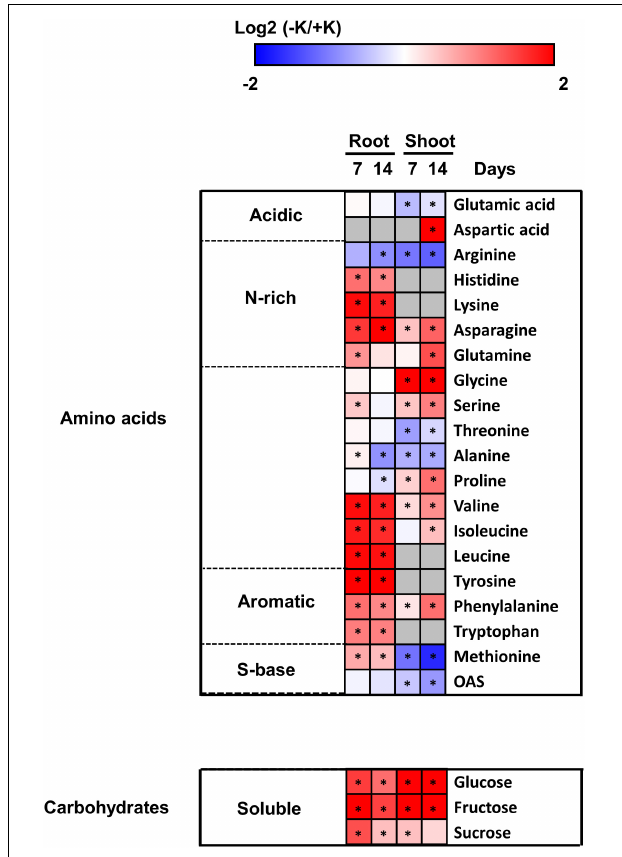
FIGURE 6 | Heatmap representation of primary metabolites in rapeseed plants exposed to K deficiency. The calculation was based on the log2 values of the ratio between –K/ + K for each of the metabolites at 7 or 14 day. Asterisks denote significant differences according to t -test ( p <